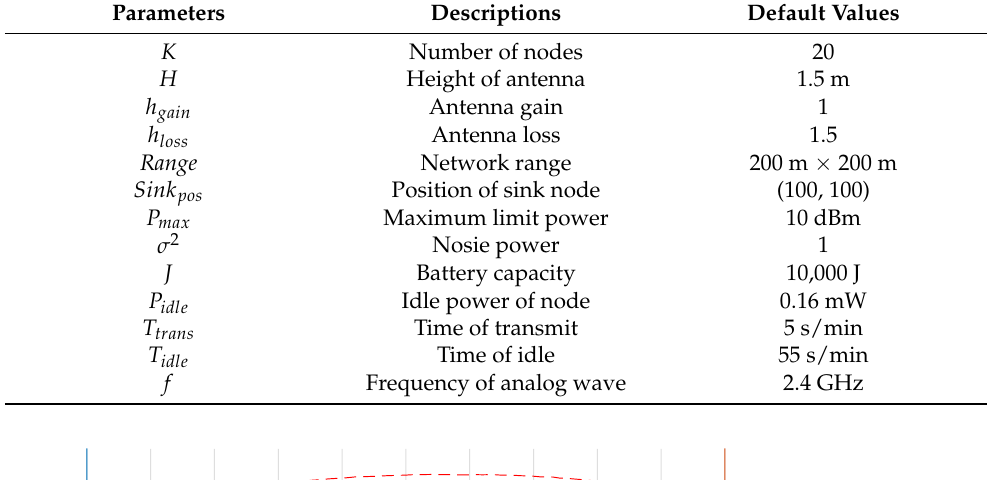
Table 1. Main notations and their default values. Parameters